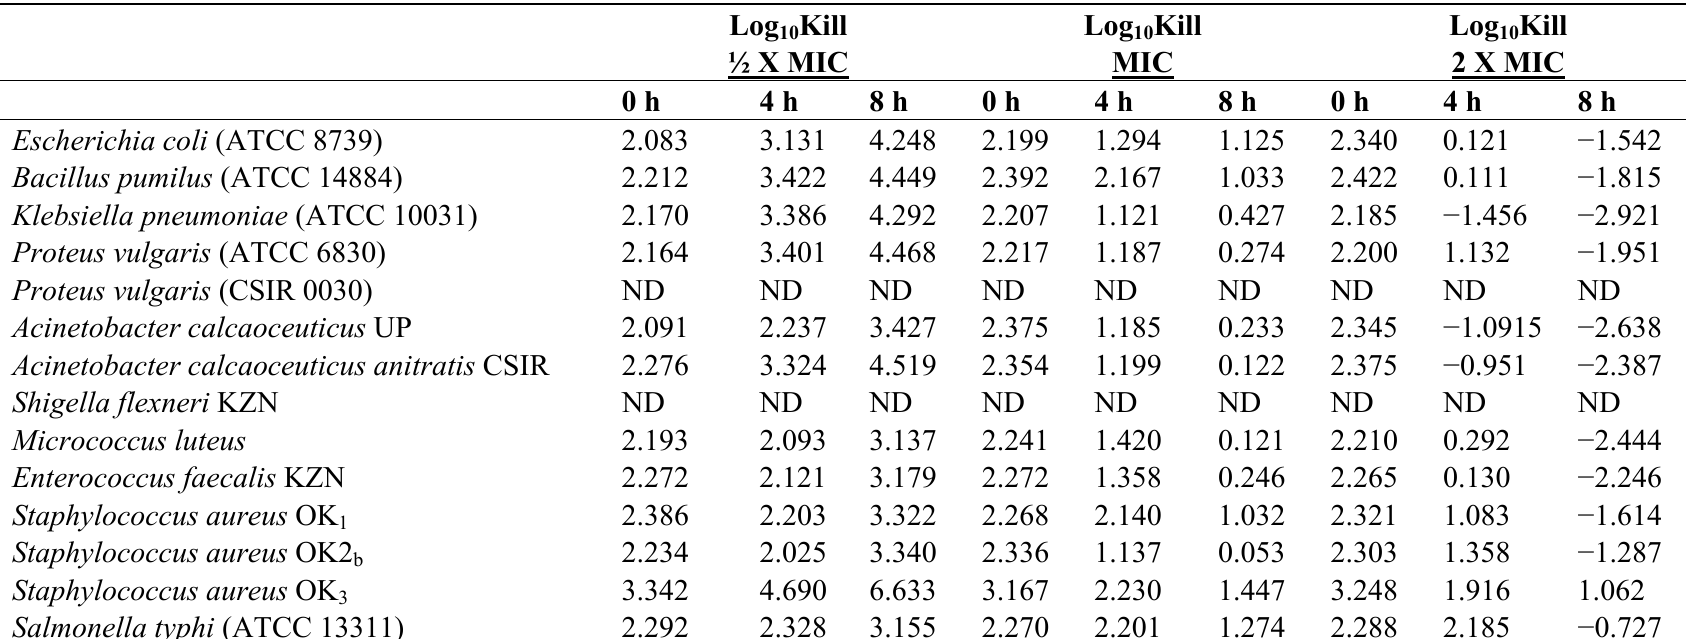
Table 2. In vitro time kill assessment of the rude methanolic stem bark of A. mearnsii